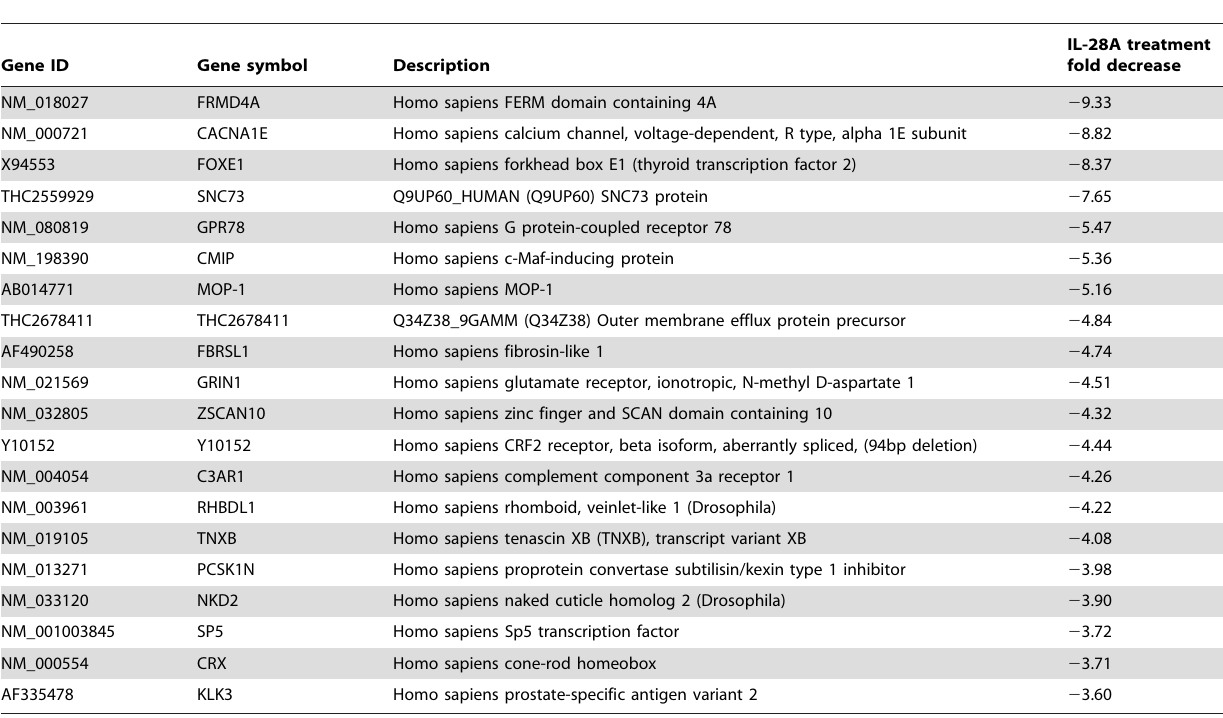
Table 4. Overview of the 20 genes whose expression was most strongly repressed (p , 0.01) by IL-28A in Huh-7 cells after 6 hours of stimulation.